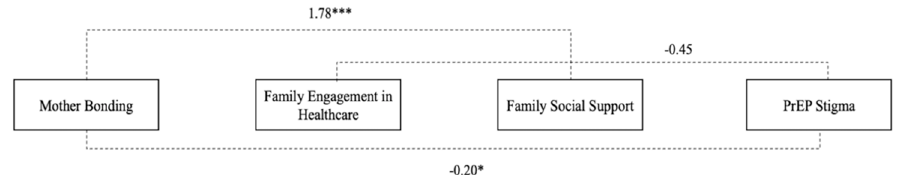
Figure 2. Indirect pathways to reduction in PrEP stigma ( n = 399) mother bonding. Note: standardized path coefficients presented. * p < 0.05; *** p < 0.001.